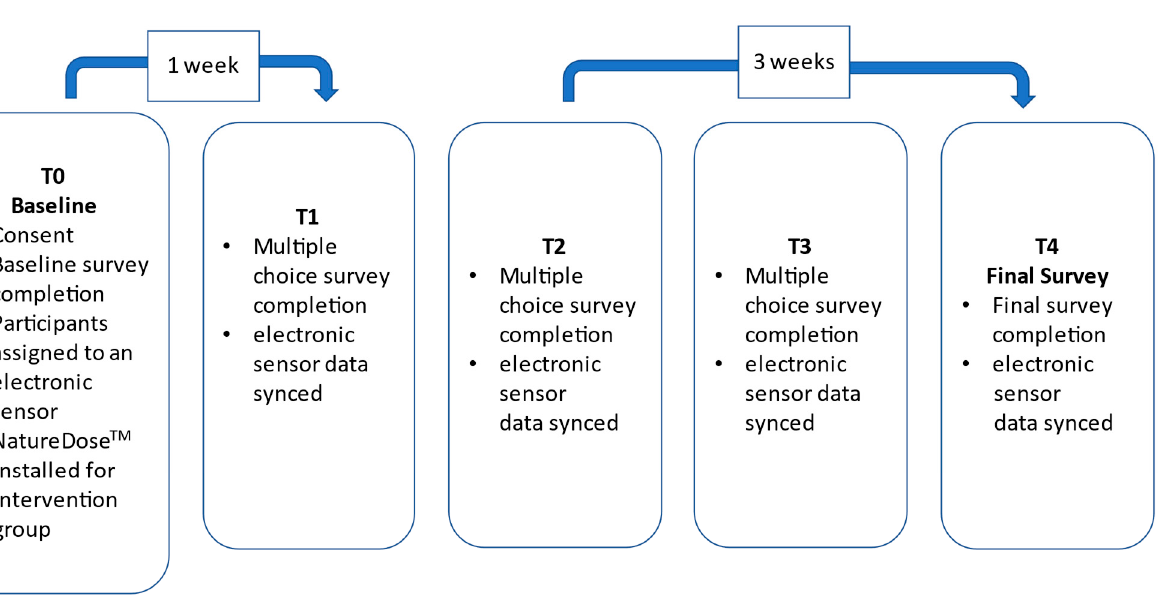
Figure 1. Data collection timeframe.